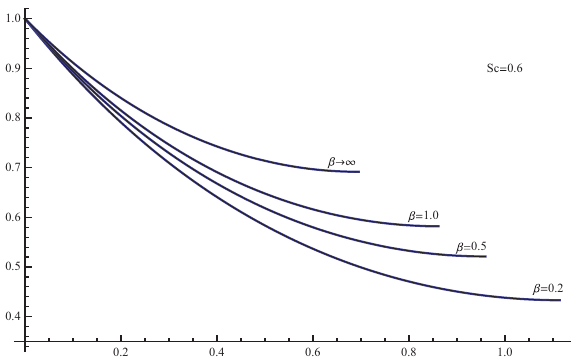
Figure 6: ( ) θ η for assorted quantities of M .